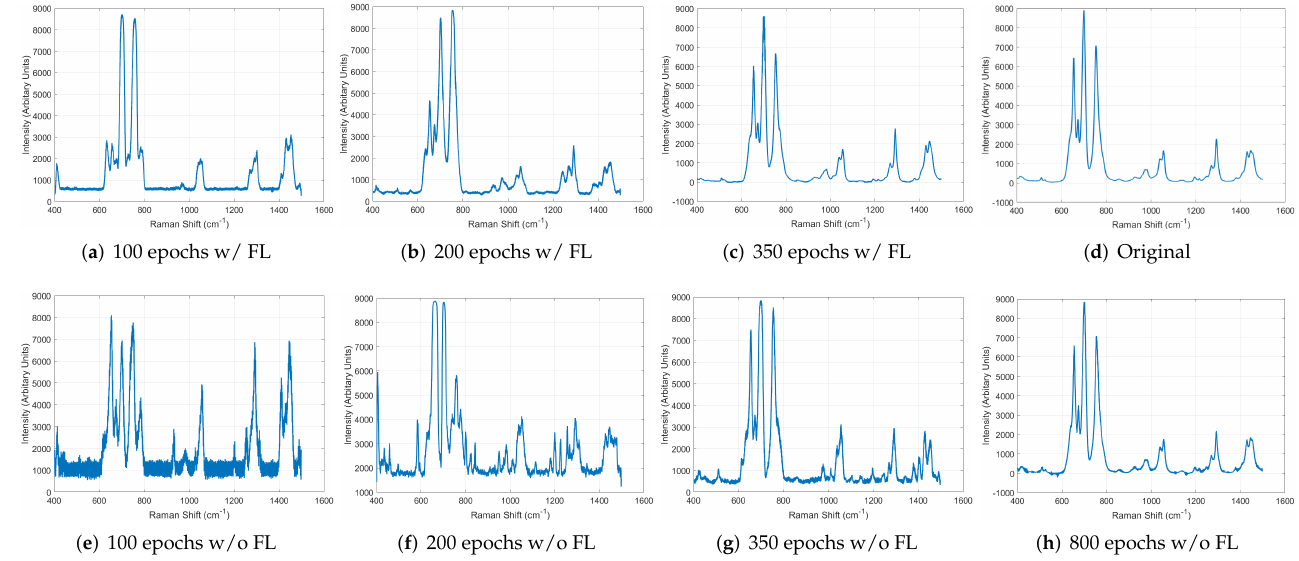
Figure 12. Performance comparison between the results with and without using